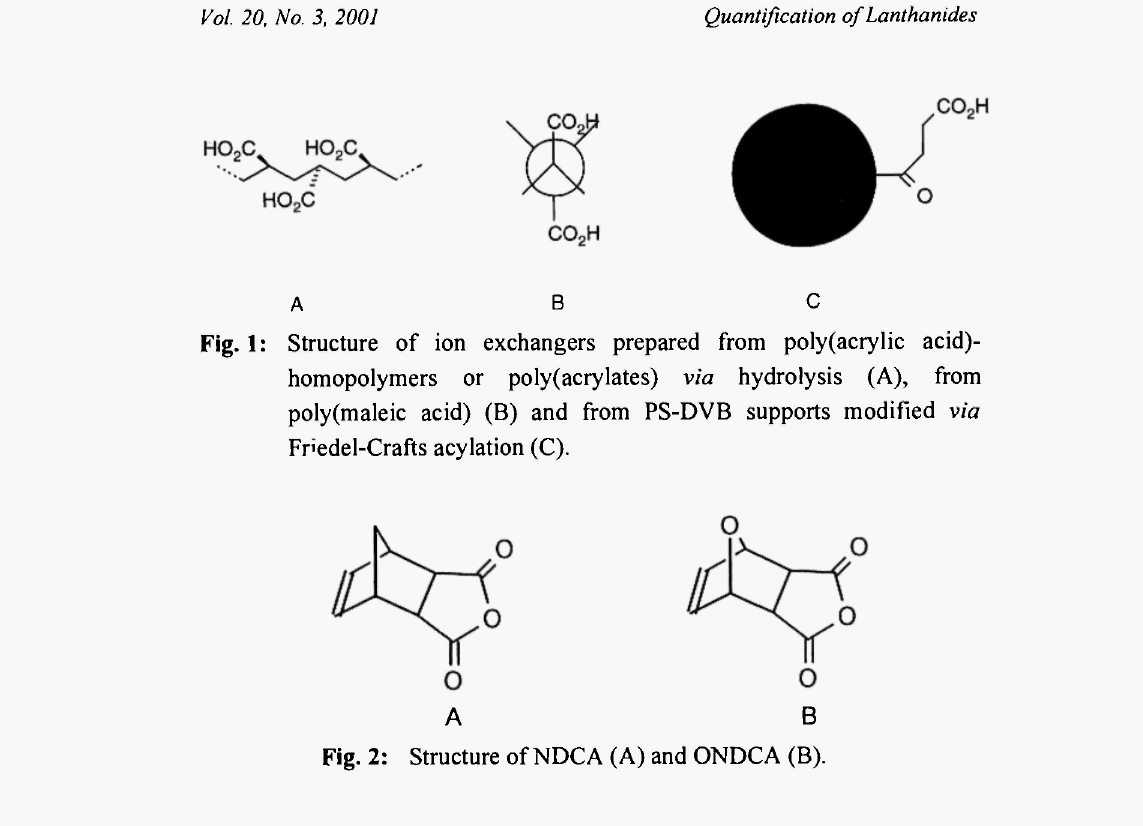
A Β Fig. 2: Structure of NDCA (A) and ONDCA